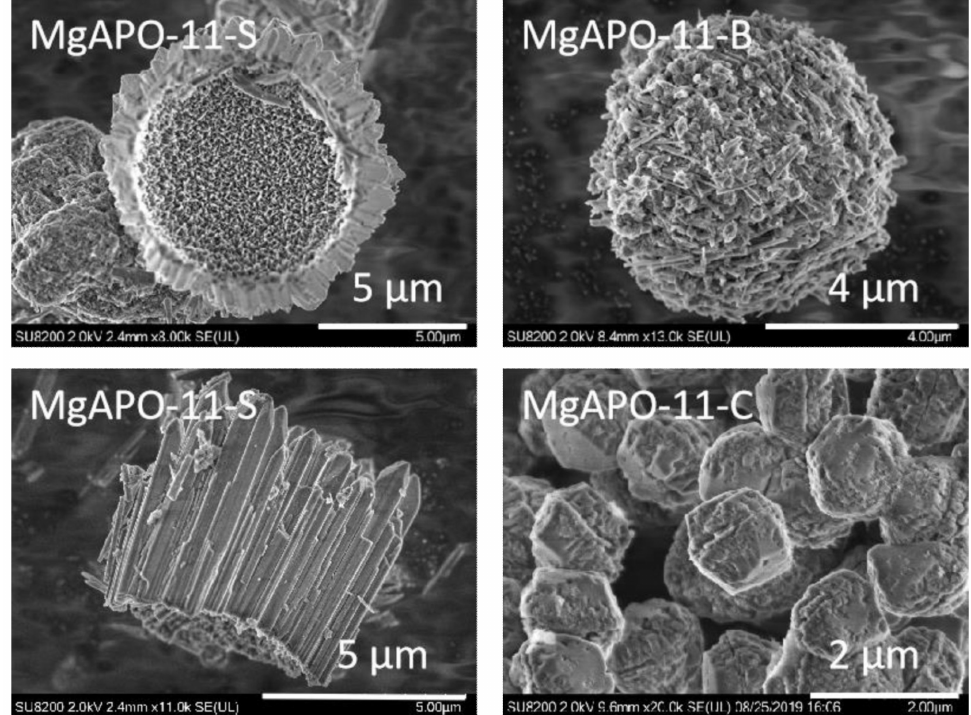
(Table 1). The Mg/Al ratio of the three samples varied from 0.06 to 0.08, corresponding to the 305–399 µ mol Mg/g sample.